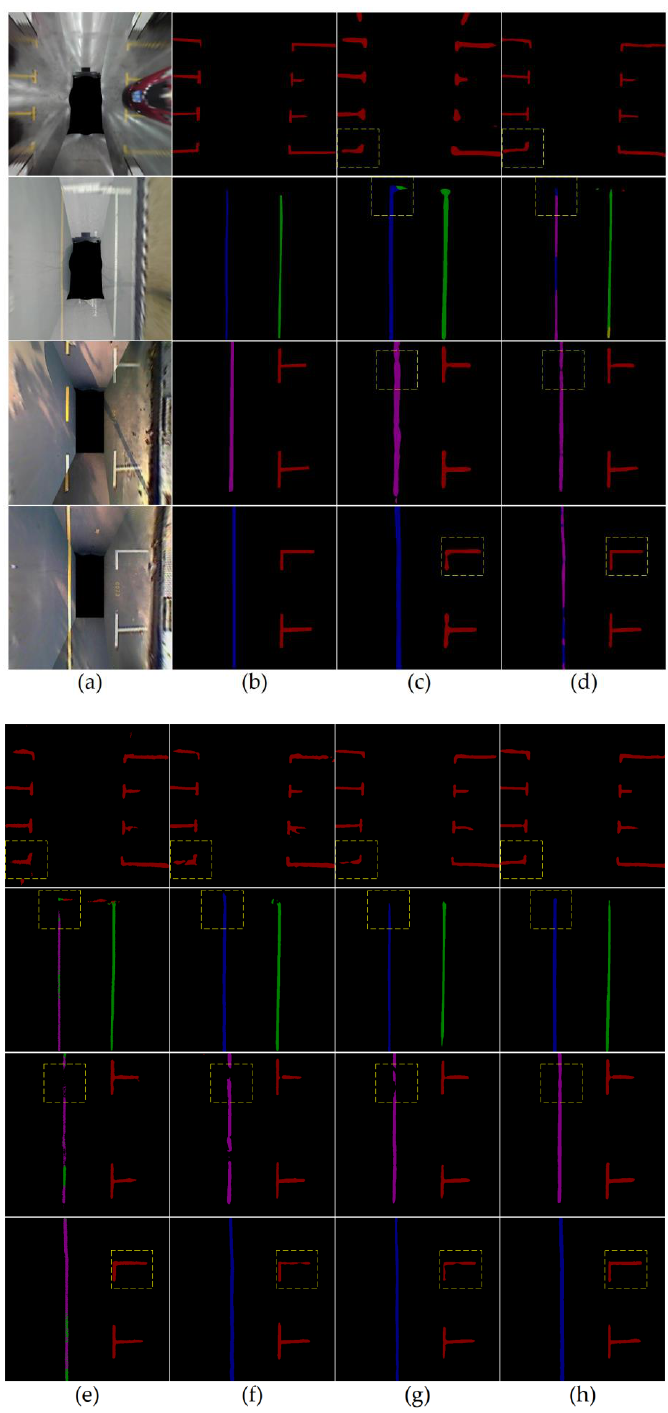
Figure 5. The final segmentation results of multiple algorithms. In the figure, ( a ) and ( b ) are the input image and ground truth in the PSV dataset, respectively, followed by inference images of FCN8 ( c ), U-Net ( d ), ENet ( e ), DeeplabV3+ ( f ), PSPNet ( g ), and our result ( h ) in the last column. In order to more clearly show the inference ability of each network for the PSV dataset and facilitate the observation for readers, we have marked the parts in the inference image that significantly differ from the ground truth with a yellow dotted box. The figure shows that the network’s accuracy in the front part is relatively low, and there is a mislabeling problem. The network in this paper has the highest accuracy and mIoU which is closest to the ground truth. parameters than the standard network. The image features can be extracted through the coarse segmentation of the upper-layer network with a reduced size image input and the detailed image features can be extracted from the lower-layer network that is a part of the standard network. Those two methods contribute to the real-time performance of the overall network. On the other hand, fusion of the coarse and detailed features extracted from the upper and lower layers, respectively, significantly improves the segmentation accuracy of the whole network. In Table 3, the mIoU of the RPSD network without the upper-layer network is 48.15% and, in Table 5, the mIoU of the whole RPSD is 67.97%, with a significant increase in the accuracy of the whole network after the fusion. Therefore, the entire RPSD network achieves real-time segmentation while maintaining high accuracy. Figure 5 shows the inference results comparison of the PSV dataset after the above network training. Columns (a) and (b) are input images and ground truth in the PSV dataset, respectively. The following columns are the contrast networks, including FCN8 [28], U-Net [29], ENet [36], DeeplabV3+ [33], and PSPNet [30], and the last column shows the results of this work. The colors are labeled according to the six classification orders in the PSV dataset. The sequence is black, maroon, green, light brown, navy blue, and purple.